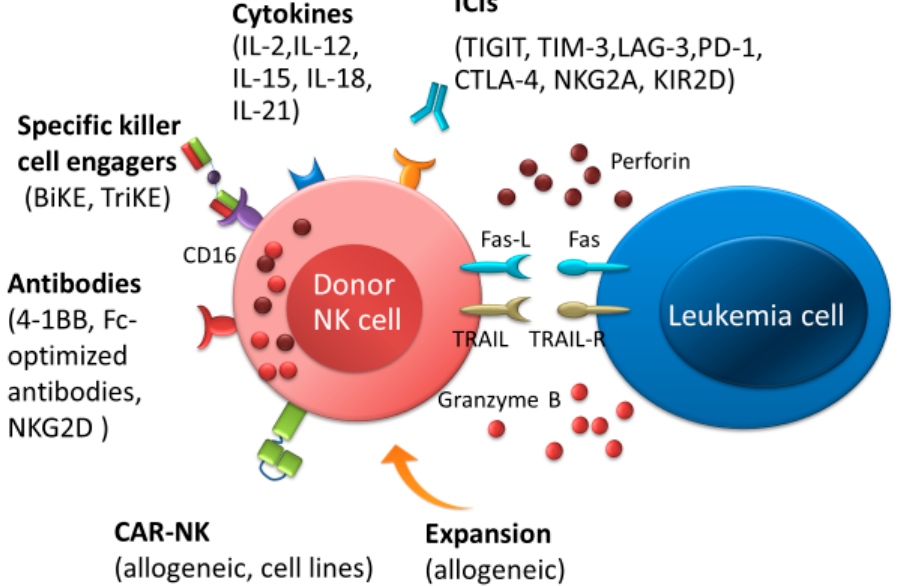
Figure 2. Natural killer (NK) cell immunotherapies after allo-HSCT therapeutic approaches for the elimination of AML. NK cells-based immunotherapeutic concepts are based on stimulating NK cells by cytokines or immune checkpoint inhibitors, promoting antibody-dependent T-cell-mediated cytotoxicity by antibodies or bispecific and trispecific killer cell engagers, and improving NK cell responses by adoptive transfer of NK cells, such as allogenic NK cells or chimeric antigen receptor NK cells. Abbreviations: ICIs, immune checkpoint inhibitors; BiKEs, bispecific killer cell engagers; TriKEs; trispecific killer cell engagers; CAR, chimeric antigen receptor.